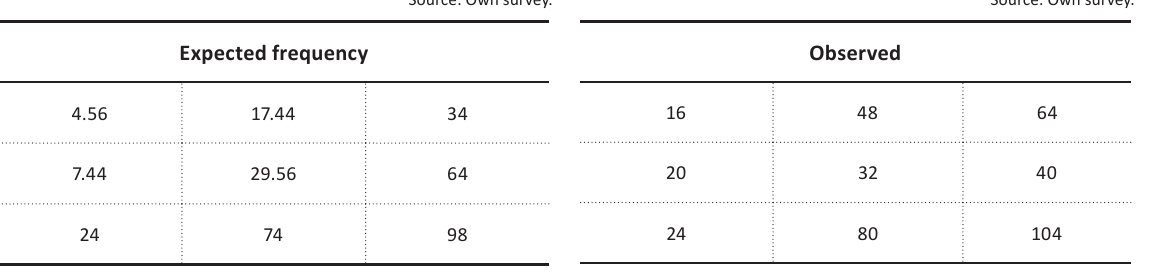
Table 5. Expected frequency for H1